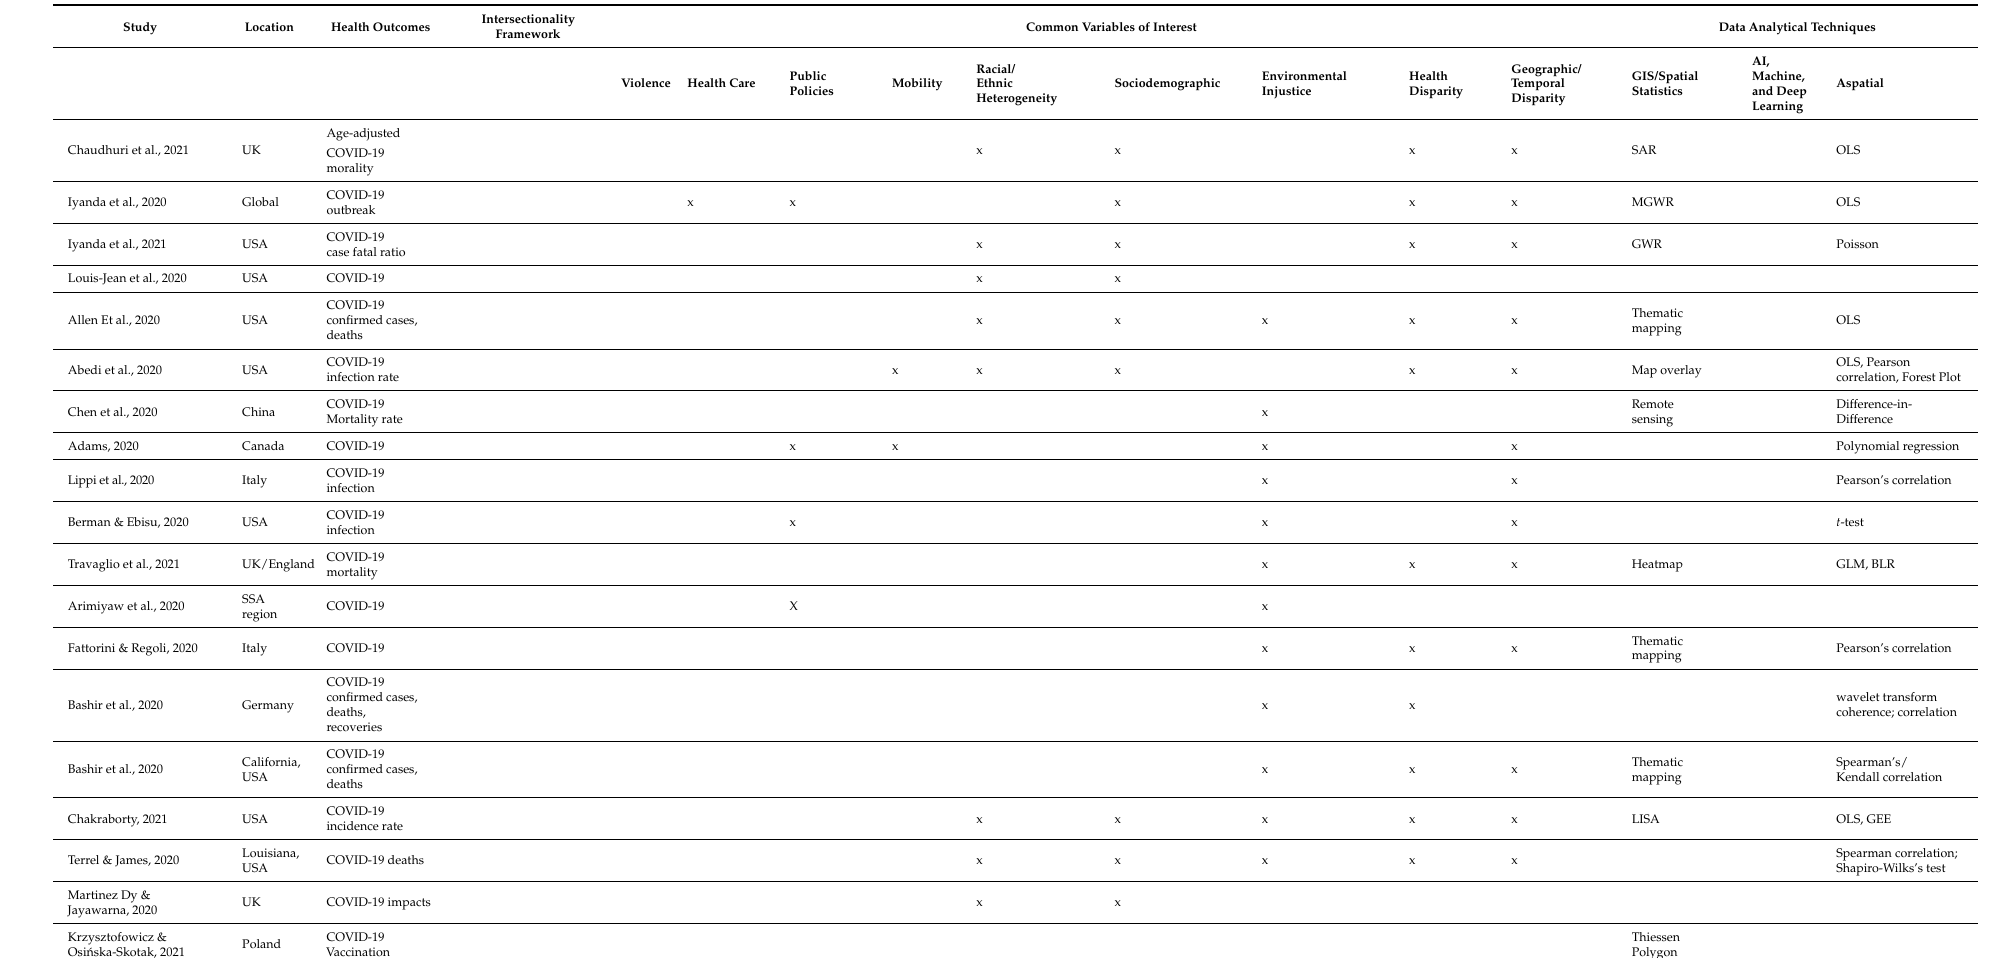
Table 2. Common variable of interest, intersectionality framework, and data analytical techniques in COVID-19 research.